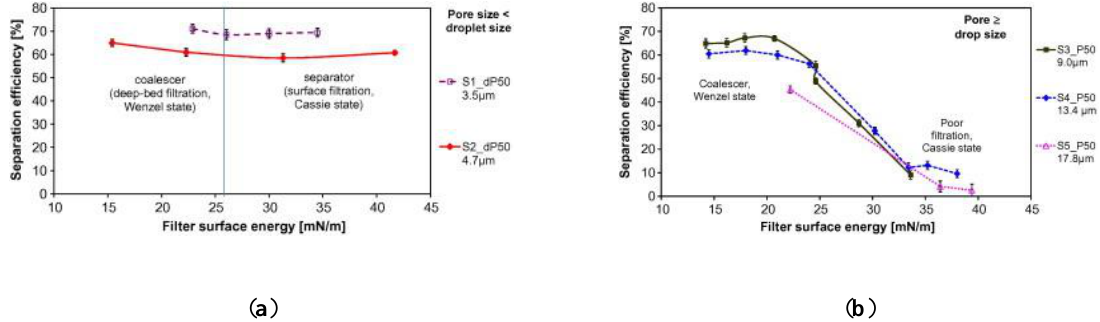
Figure 9. Influence of substrate surface energy on oil-in-water emulsion separation performance for ( a ) pore size < dispersed droplet size, pressure drop 2.2 bar and ( b ) pore size ≥ dispersed droplet size, pressure drop 1.1 bar.